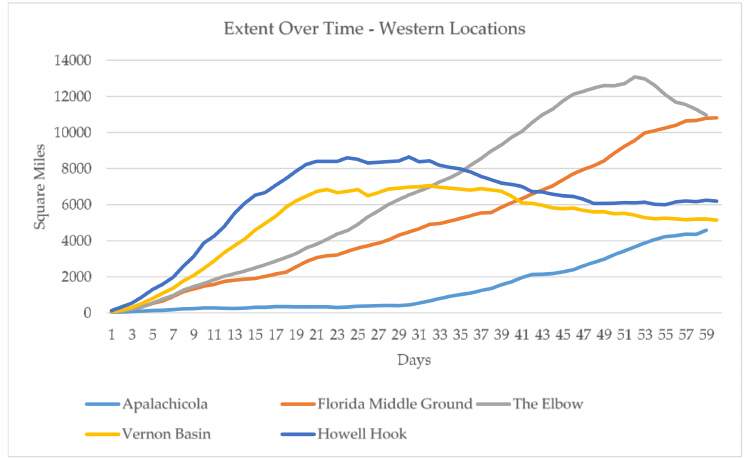
Figure 4. Plume extent as a function of time for the western